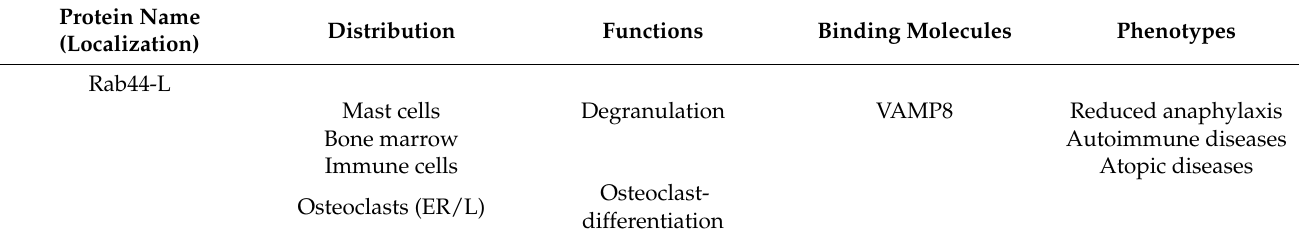
Table 1. Summary of distribution, localization, functions, binding proteins, and the phenotypes or diseases associated with large Rab